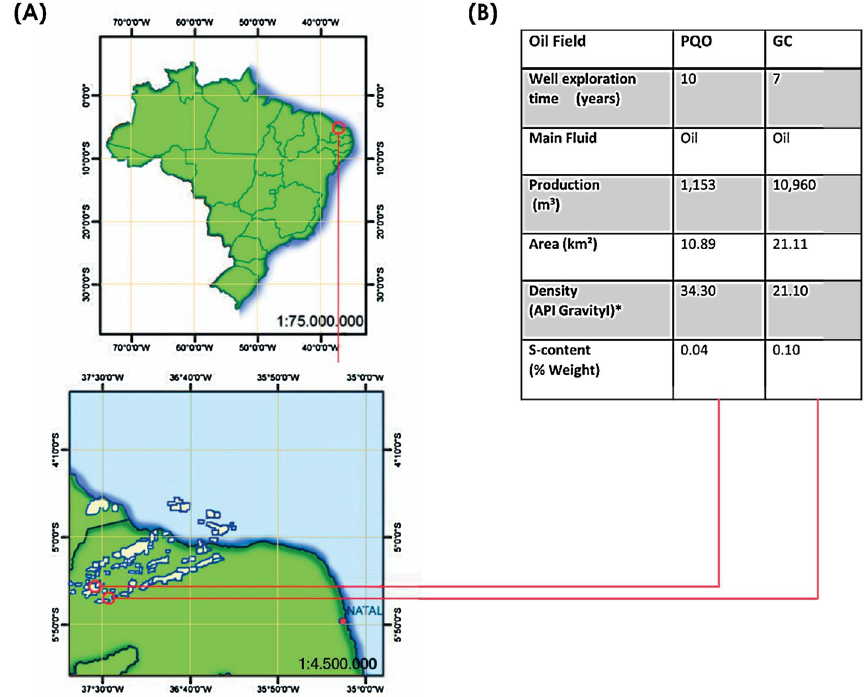
Figure 1. (A) Geographical location (B) Characteristics of Periquito (PQO) and Galo de Campina (GC) onshore oilfields from